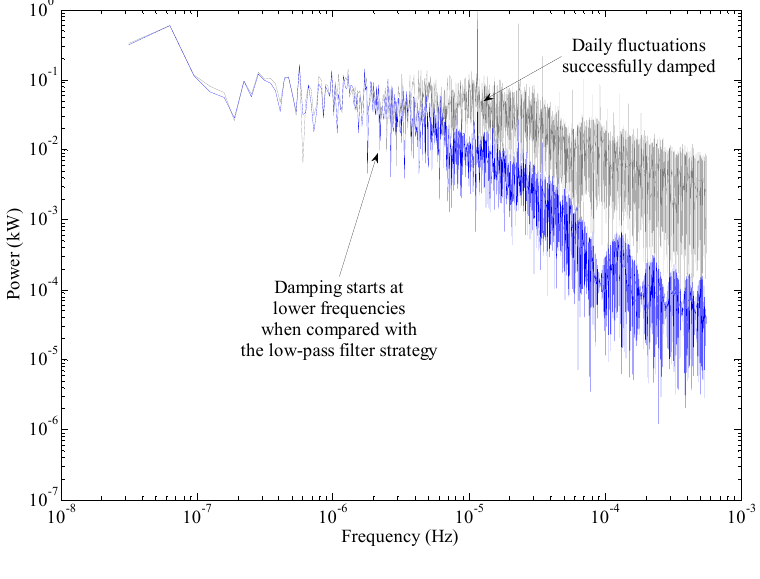
Figure 19. Spectral analysis of the net power (grey) and power exchanged with the grid applying the proposed strategy